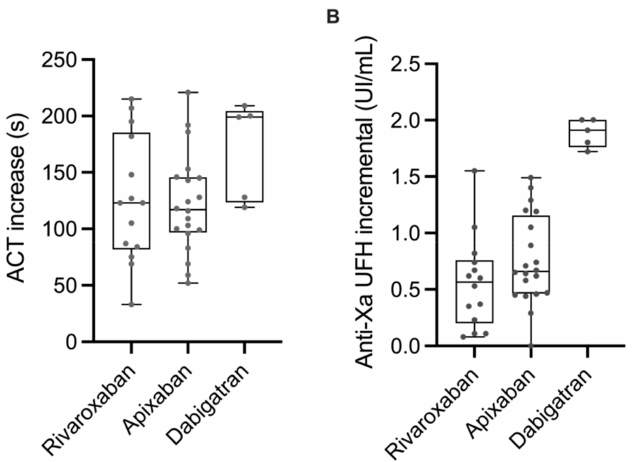
Figure 2. Increase in ACT ( A ) and UFH anti-Xa activity ( B ) after the initial bolus of UFH in patients treated with rivaroxaban, apixaban, or